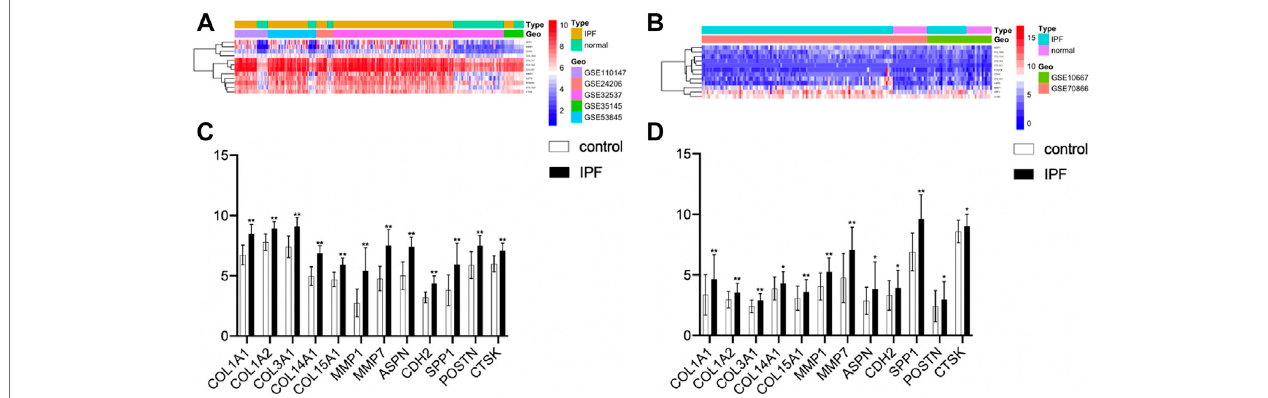
FIGURE 6 | Correlation analysis of hub genes. (A) Heatmap of the training group. (B) Heatmap of the validation group. (C) Expression levels of twelve hub genes (healthy control samples vs IPF samples) from the training group. (D) Expression levels of twelve hub genes from the validation group (* p < 0.05, ** p < 0.01).